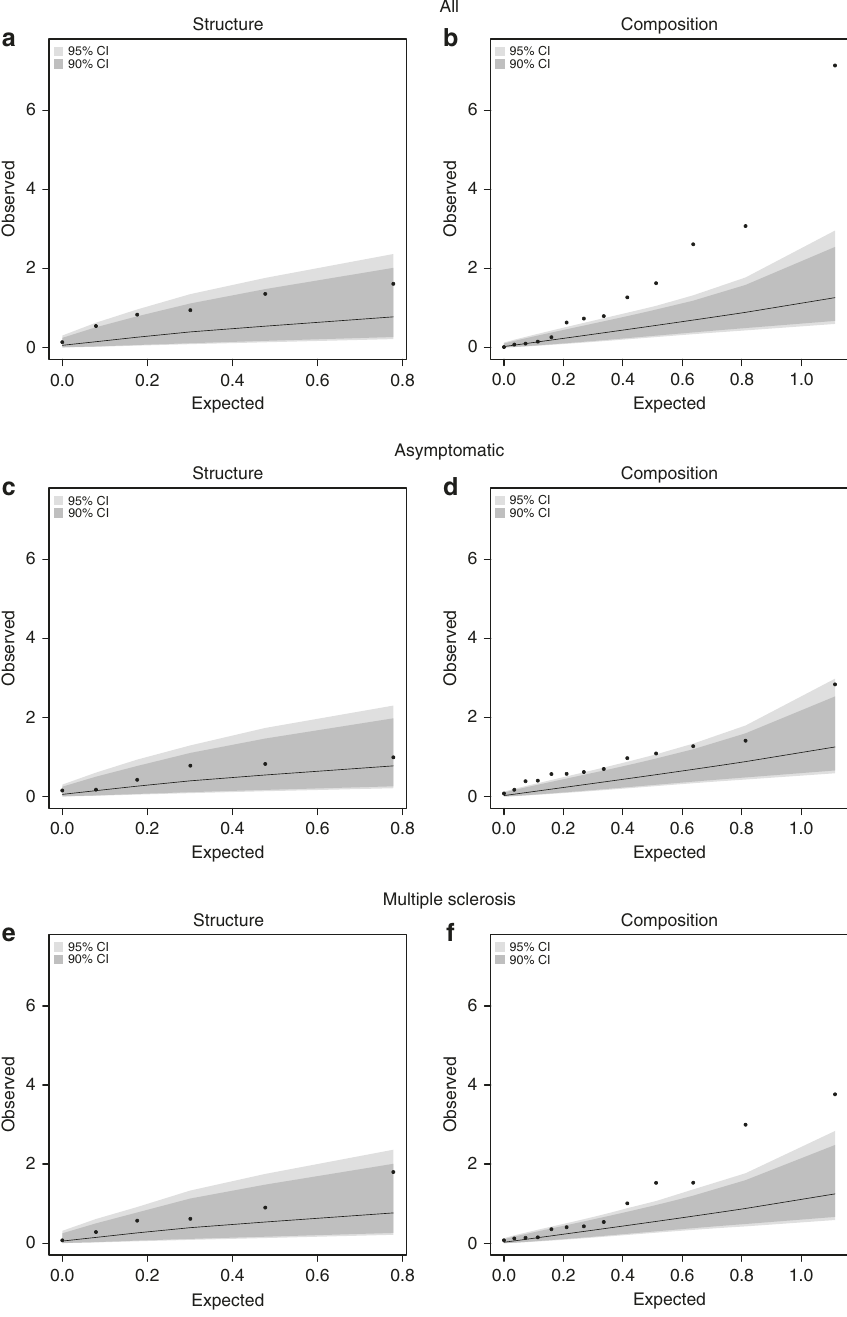
of all participating sites (Partners HealthCare, National Institutes of Health, and University of Pittsburgh) approved the study. All participants provided written informed consent.